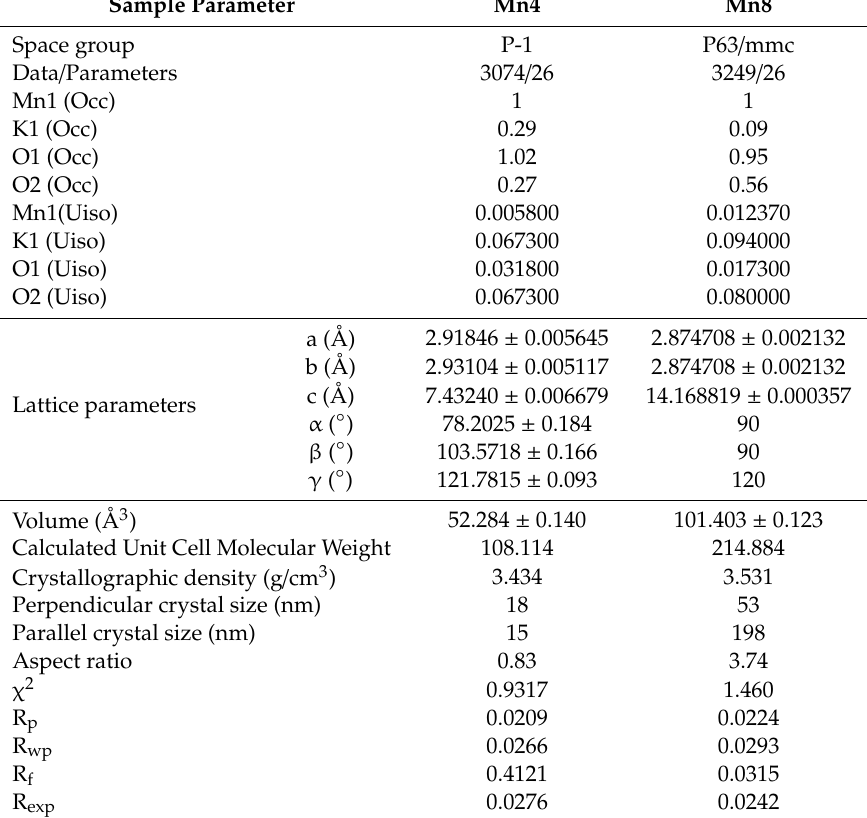
Table 2. Summary of Rietveld refinement results for Mn4 and Mn8 materials.